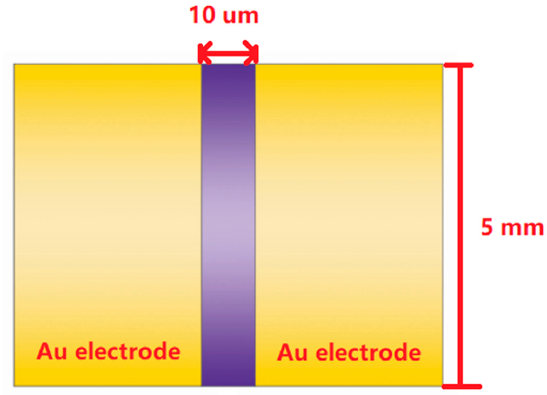
Figure 1. Scheme of films on substrates between the electrodes used in this work.